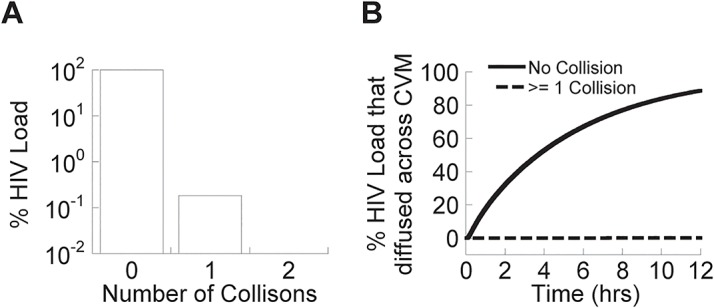
Estimating the number of collisions of HIV virions.The number of collisions between (A) HIV virions in the vagina, and (B) HIV virions that have diffused across CVM and reached the vaginal epithelium, over the first 12 hours post deposition, assuming a viral load of 4.5 log10 RNA copies per mL, the mean peak viral load for HIV in semen of acutely infected males most likely to transmit HIV [16].